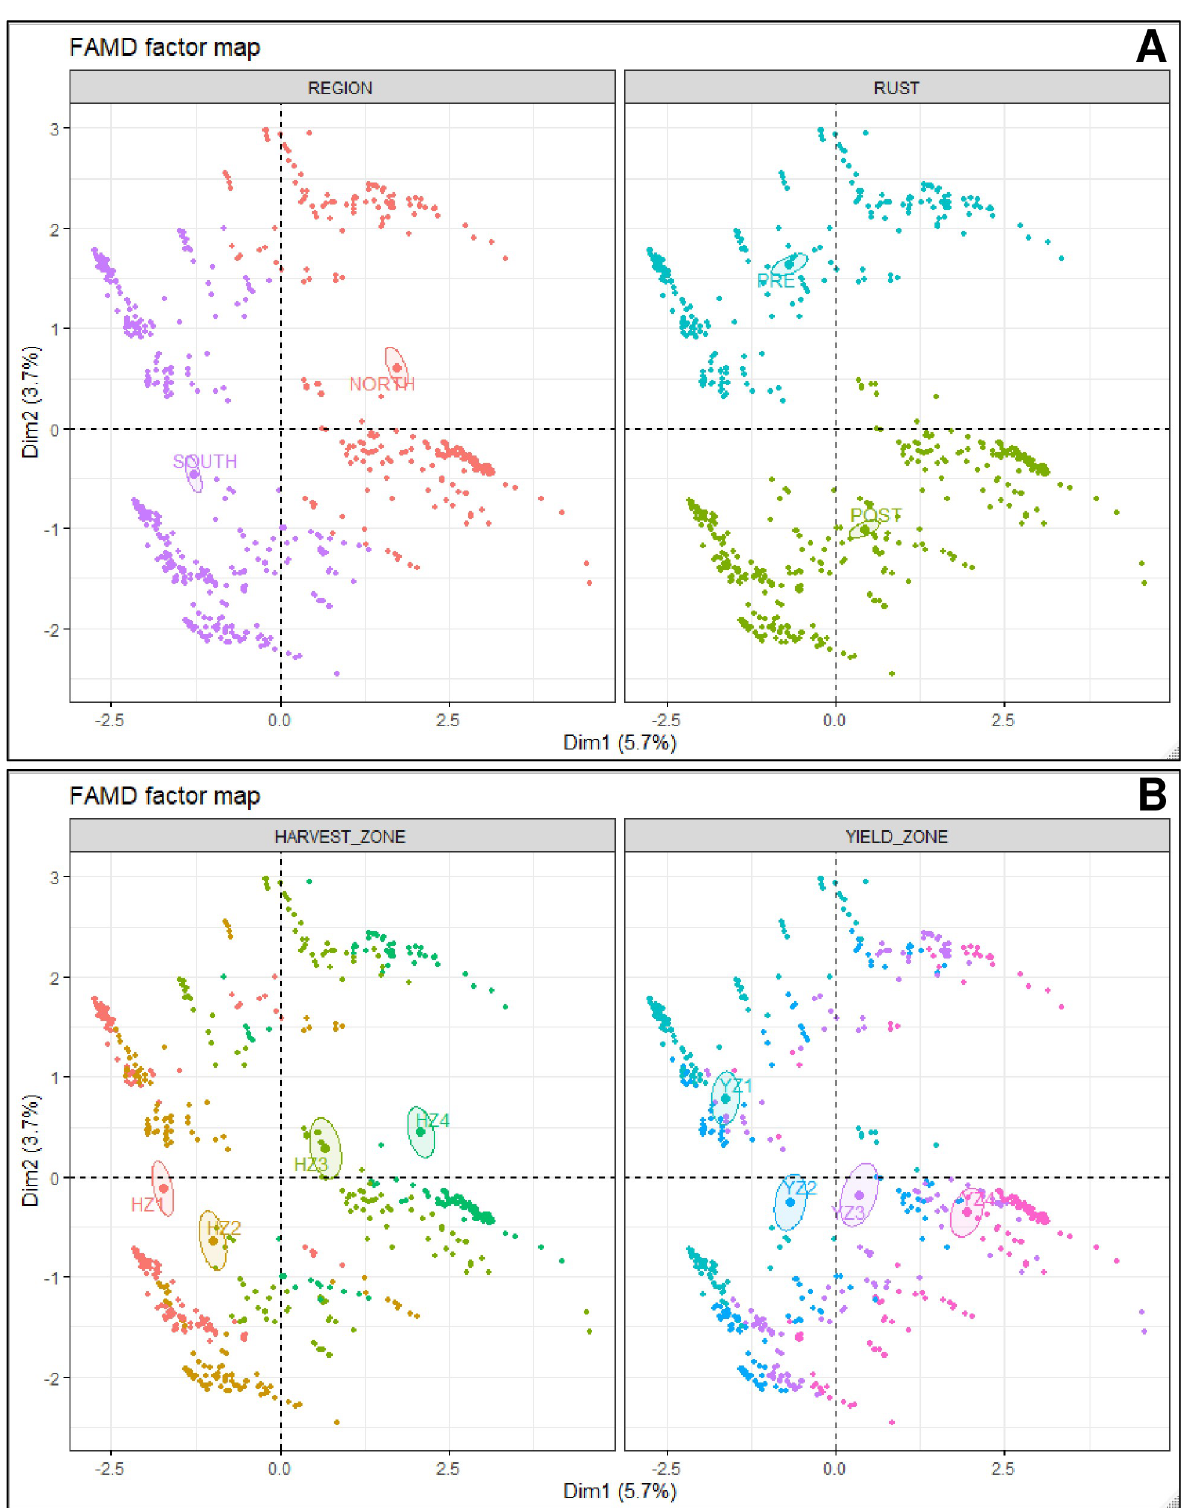
Fig 2. FAMD factor maps obtained from the factor analysis with mixed data approach (FAMD analysis), showing the variance maximizing distribution patterns of the total per hectare economic loss (due to 23 diseases) data points (= 588) in the map space and their clustering patterns based on ( A ) region and pre- and post-discovery of rust and ( B ) harvest and yield zones. Diseases = Anthracnose, bacterial blight, brown stem rot,